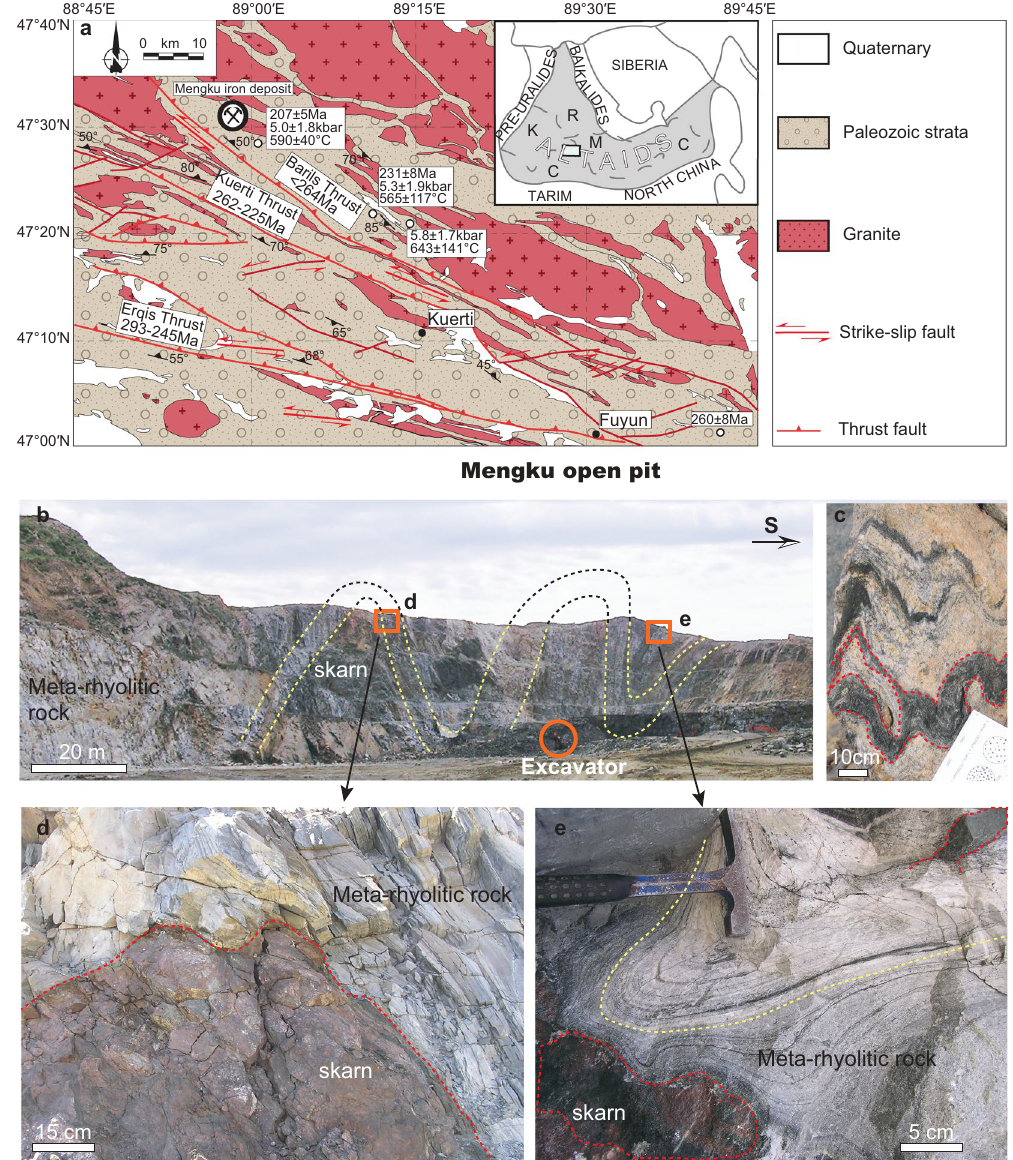
Figure 1. ( a ) The geological map of the Mengku iron deposit in the Fuyun. Small black open circles with the age value, pressure, temperature are the results of Briggs 13 . ( b – d ) show that the skarn mineralization is strata bounded by the deformed host rocks in different scales. ( e ) shows the skarn cut across the fold axis of the hosting rock, indicating post-deformation formation. The locations of ( d , e ) are marked in the ( b